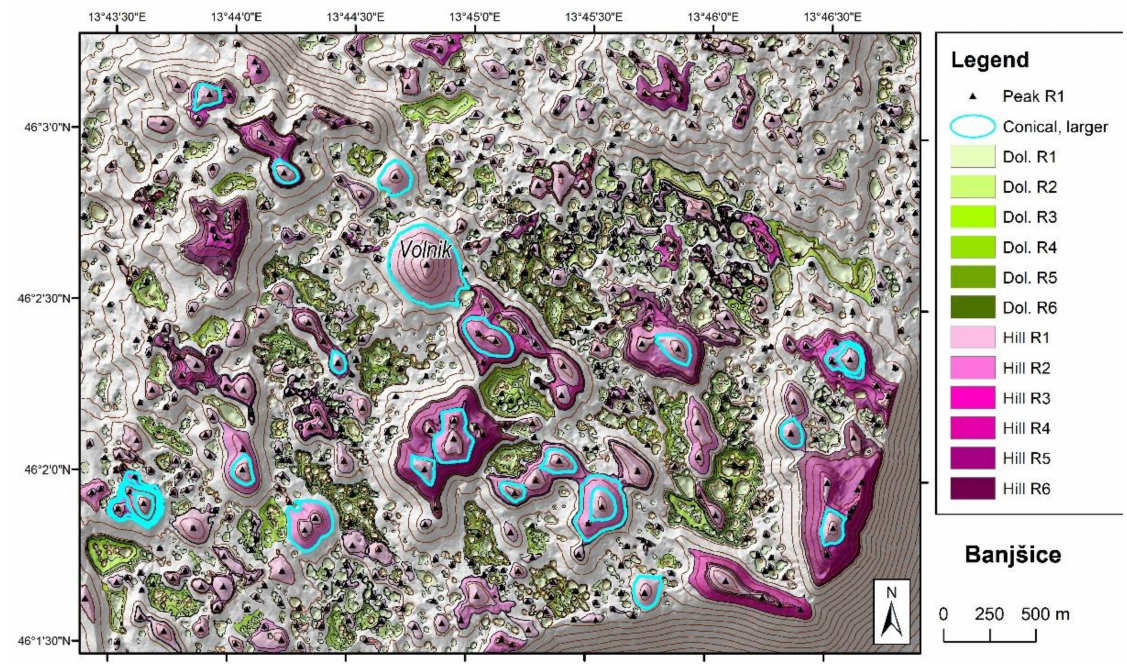
Figure 5. Hillshade map of the Banjšice study area with dolines and karst hills of different ranks. Hills highlighted by cyan outlines are the more circular and larger conical hills (circularity > 0.7, height > 20 m). For further explanation see the Results section in text. Contour interval is 10 m. Volnik peak is the most ideal conical hill of the study areas in this